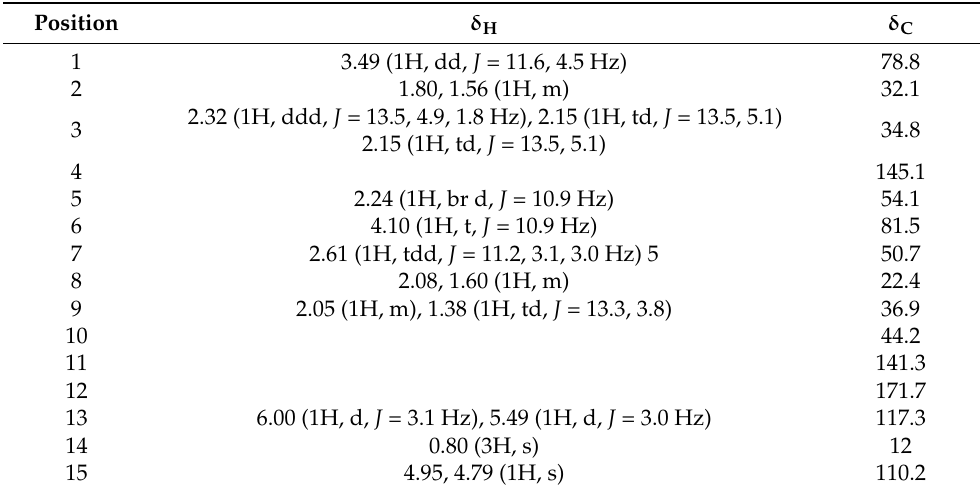
Table 2. 1 H and 13 C NMR Spectral Sdata for Santamarine